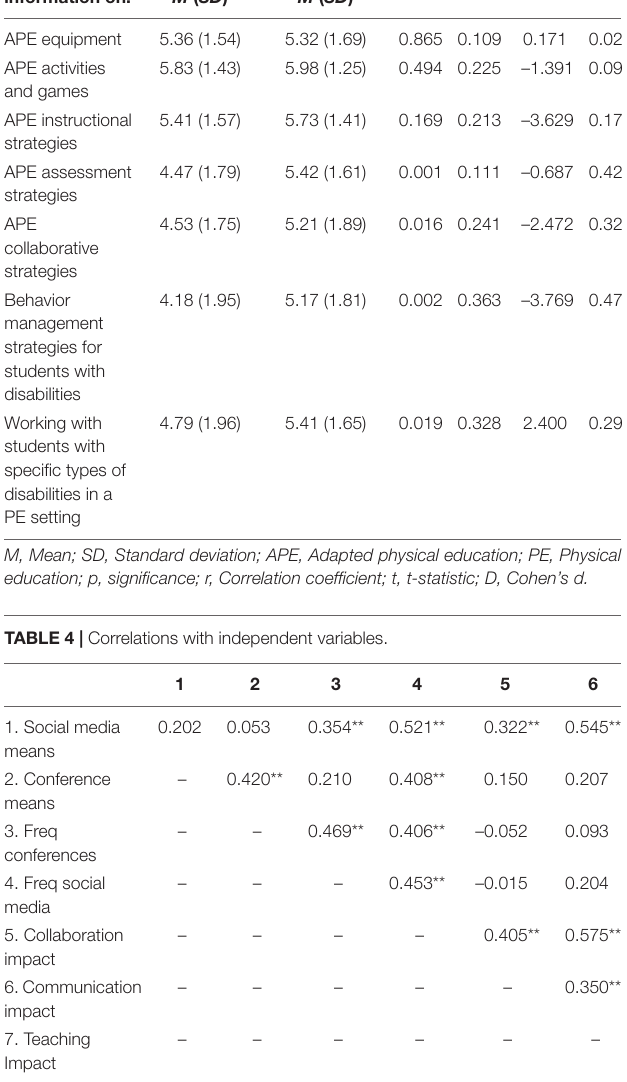
... to gain information on: